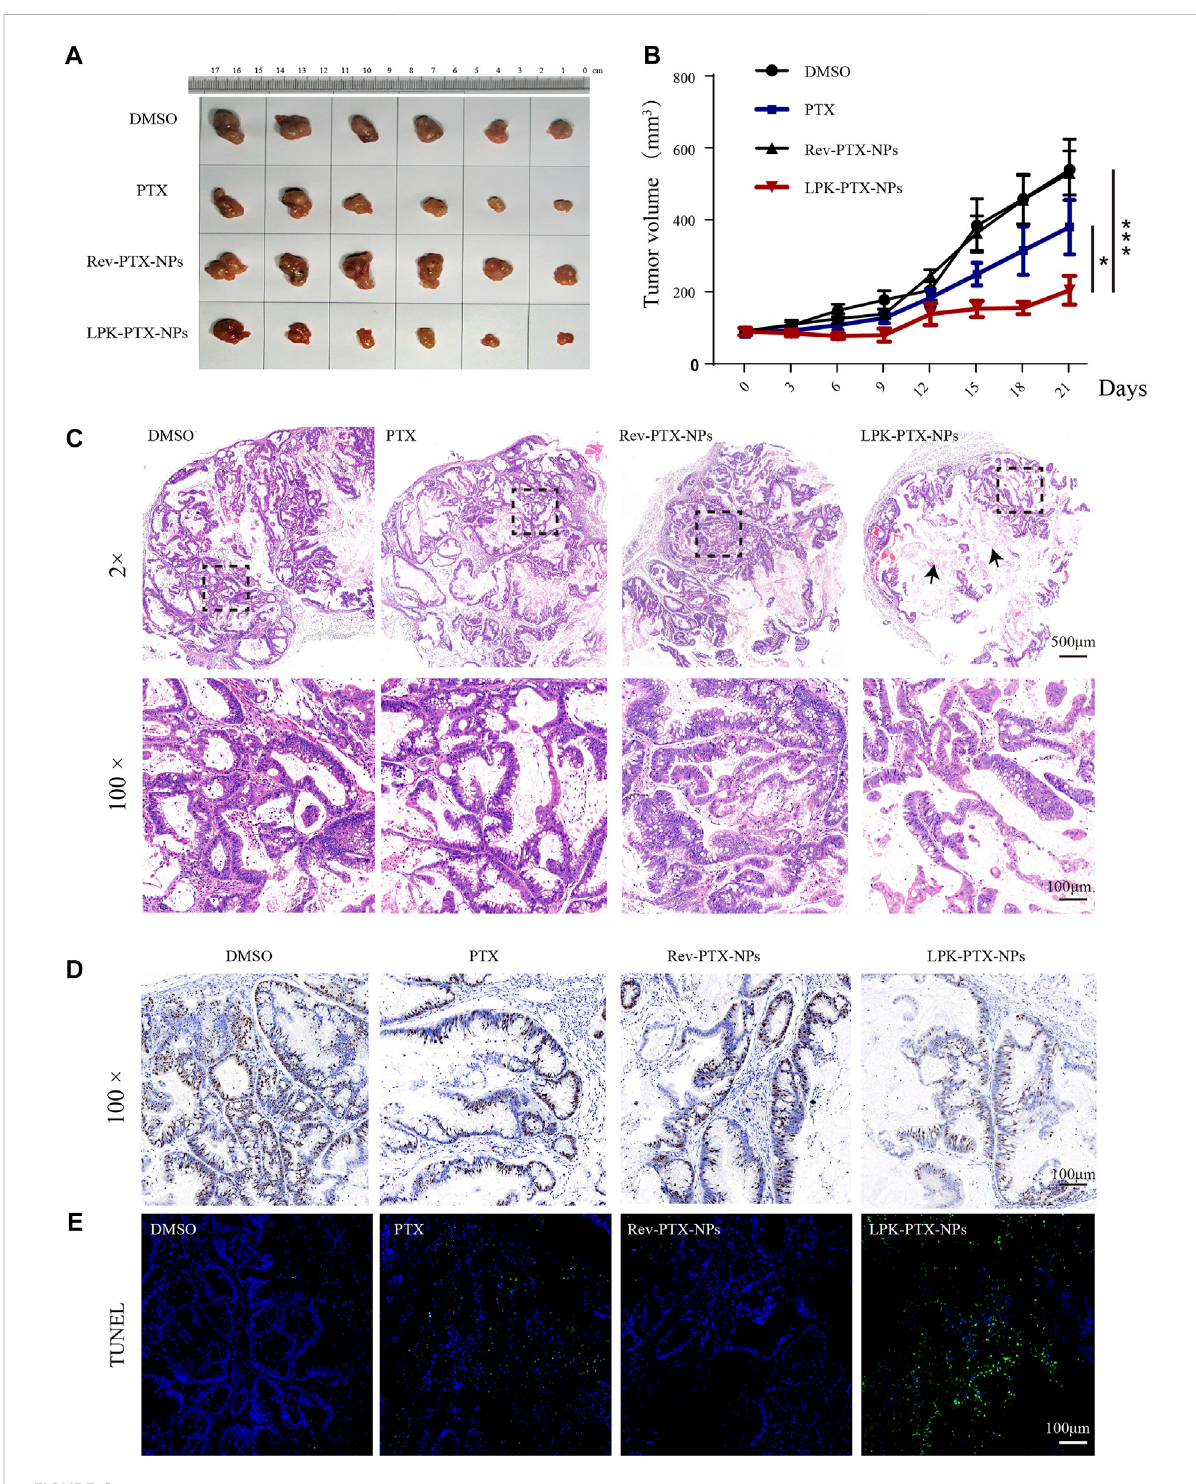
FIGURE 6 Invivo antitumoractivityofLPK-PTXNPs. (A) Thexenograftedtumorafter21 daysofdifferenttreatmentsfromthegroupsindicated. (B) Analysis of tumor volume of different treatments via intravenous injection. The data were presented as the means ± standard deviation. n = 6, * p < 0.05. (C) H&E staining analysis of CRC sections from each group. Histologically, PDX tumor tissues preserved the heterogeneity of the original tumor. Tumor treated with the LPK-PTX NPs were substantially consists of connective tissues (Arrow indicated). Ki-67 (D) and TUNEL staining (E) in tumor tissue sections from different groups. Ki-67-positive staining was indicated by brown and nuclei were stained by blue. TUNEL-positive cells